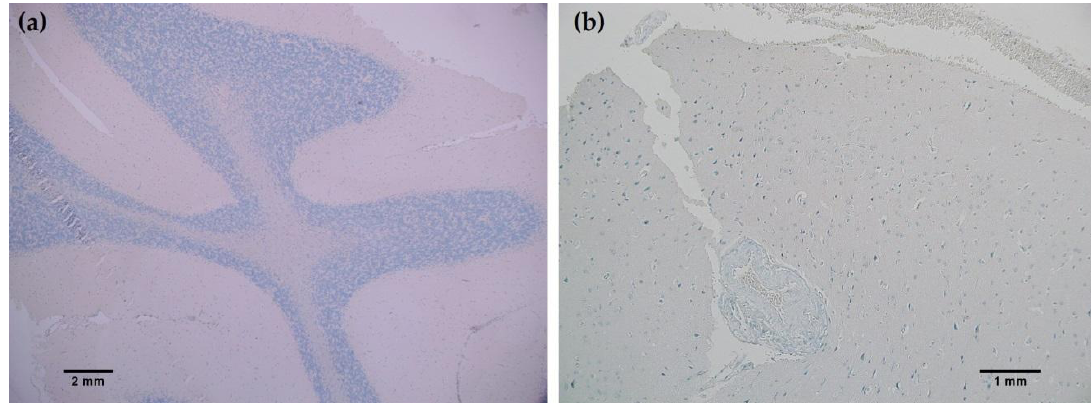
Figure 5. MRQ-67 immunohistochemistry (IHC) staining results in normal brain: ( a ) No observed reactivity in the normal cell types that constitute the gray and white matter in the cerebellar region of the brain (40×); ( b ) No observed reactivity in normal cerebral nervous tissue (100×).